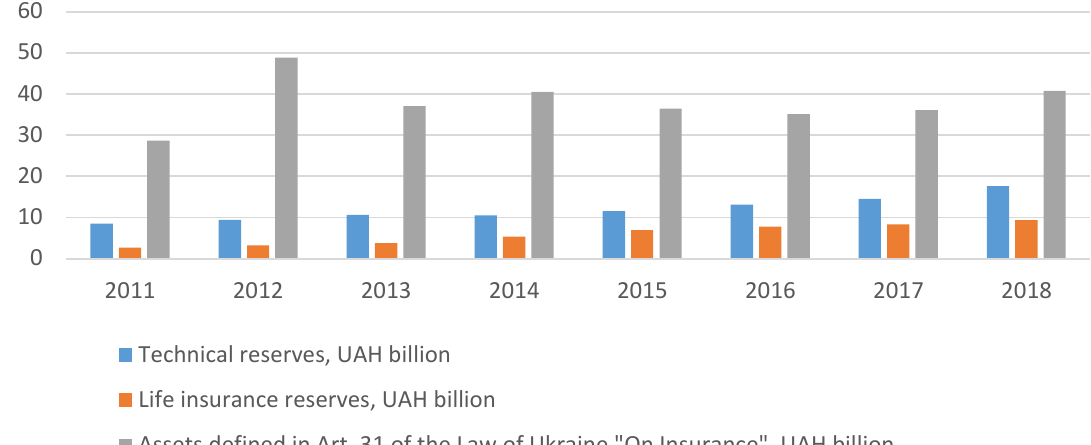
Figure 1. Amount of investment assets and insurance reserves of Ukraine in 2011–2018, UAH billion